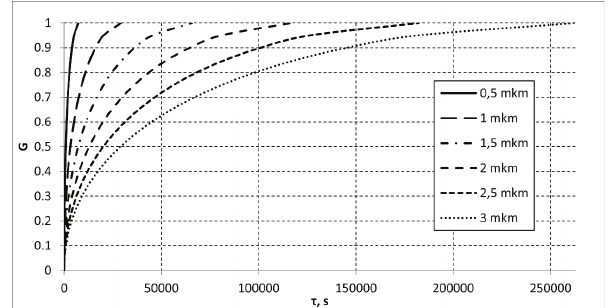
Table 2: Descriptive statistics results of simulation output K values.